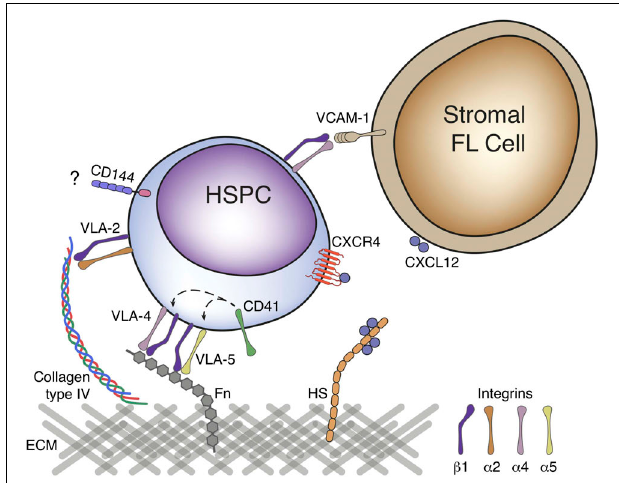
FIGURE 3 | Molecular mechanisms of fetal liver colonization. HSPC express a variety of cell adhesion molecules in their surface that can favor attachment to a specific location. β 1 integrin is essential for colonization of FL by HSPC and can bind to the ECM components fibronectin and type IV collagen through dimerization with α 4 and α 5 or α 2 integrins, respectively. VLA-4 and VLA-5 binding to fibronectin has been proposed to be modulated by CD41. VLA-4 ( α 4 β 1 integrin) can also mediate cell-cell interactions by binding with VCAM-1, expressed on the surface of FL stromal cells. Expression of the cadherin CD144 in HSCs as they emerge is assumed to play a role in the organ colonization, although no binding partner has been described in FL. CXCL12, a potent chemoattractant is expressed by FL stromal cells and binds to CXCR4, expressed on the surface of HSPC. CXCL12 gradients can be generated as this chemokine binds to proteoglycans in the ECM, namely to heparan sulfate (HS). HSPC, hematopoietic stem and progenitor cell; FL, fetal liver; ECM, extracellular matrix; VLA, very late antigen; Fn, fibronectin; HS, heparan